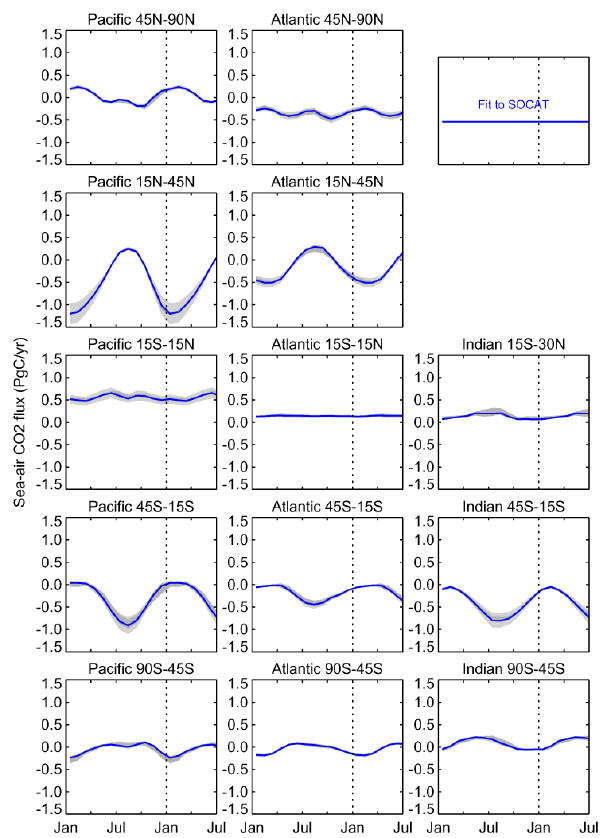
Fig. 6. Monthly mean seasonal cycle of sea–air CO 2 fluxes, esti- mated by fitting the diagnostic scheme to SOCAT data (run SFC , blue). The grey shading around the standard result comprises sen- sitivity cases listed in Sect. 3.3. Fluxes have been integrated over latitude bands split into ocean basins (including open ocean, coastal areas and marginal seas; panels in geographical arrangement). Sea- sonal cycles have been calculated over the period 1997–2009; the first half year is repeated for clarity.